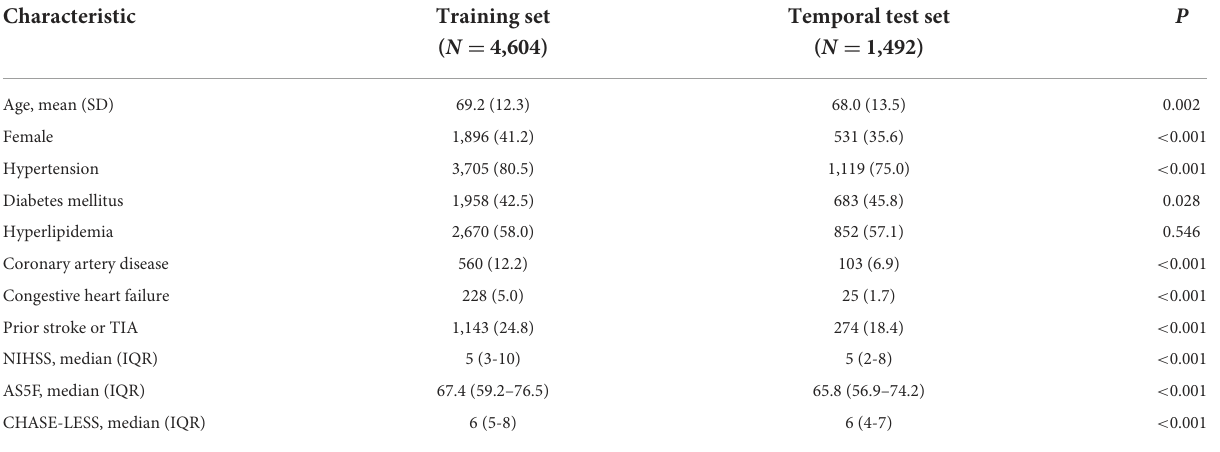
TABLE 1 Characteristics of the study